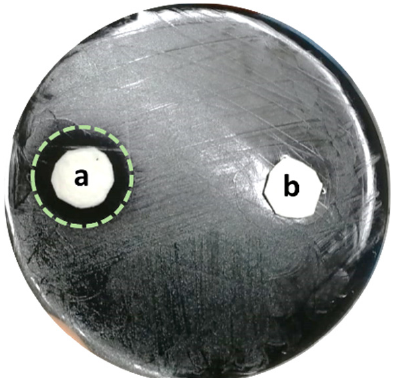
Figure 3. Zone of Inhibition Test on Legionella pneumophila SG 2–16: a s-PBC@PP coupon surrounded by an inhibition zone (green dashed line); b PP coupon.